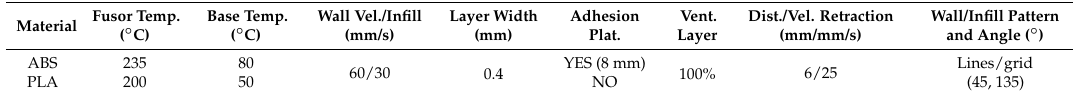
Table 5. The remaining manufacturing parameters specified for each